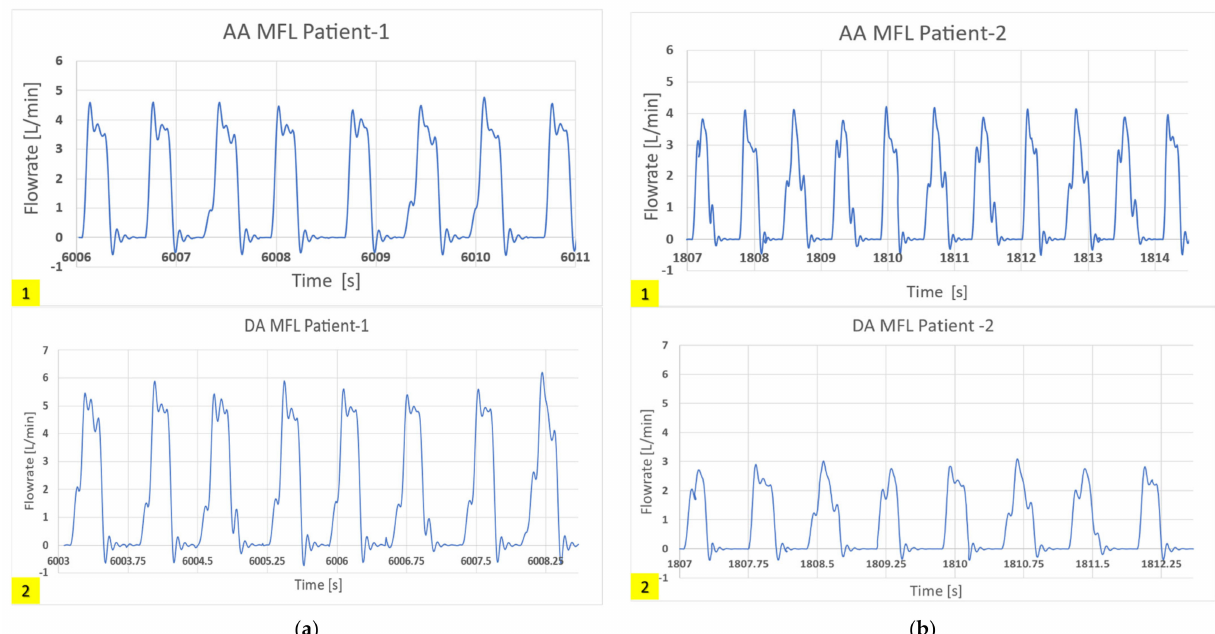
Figure 17. In-vitro results showing hemodynamic flow rate waveforms (in L/min) acquired at the following locations in the MFL are 1. AA conduit in HCSII anatomy, 2. DA conduit in HCSII anatomy for ( a ) the experimental simulation of patient-1 case (CO = 2.99 [L/min]), ( b ) the experimental simulation of patient-2 case (CO = 1.75 [L/min]).